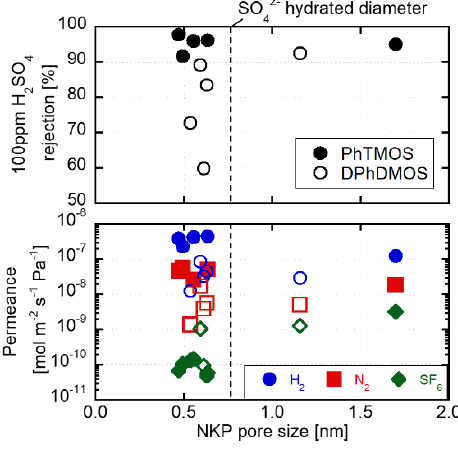
Figure 5. The NKP pore size of prepared membrane-derived gas permeance performance and H 2 SO 4 rejection. H 2 SO 4